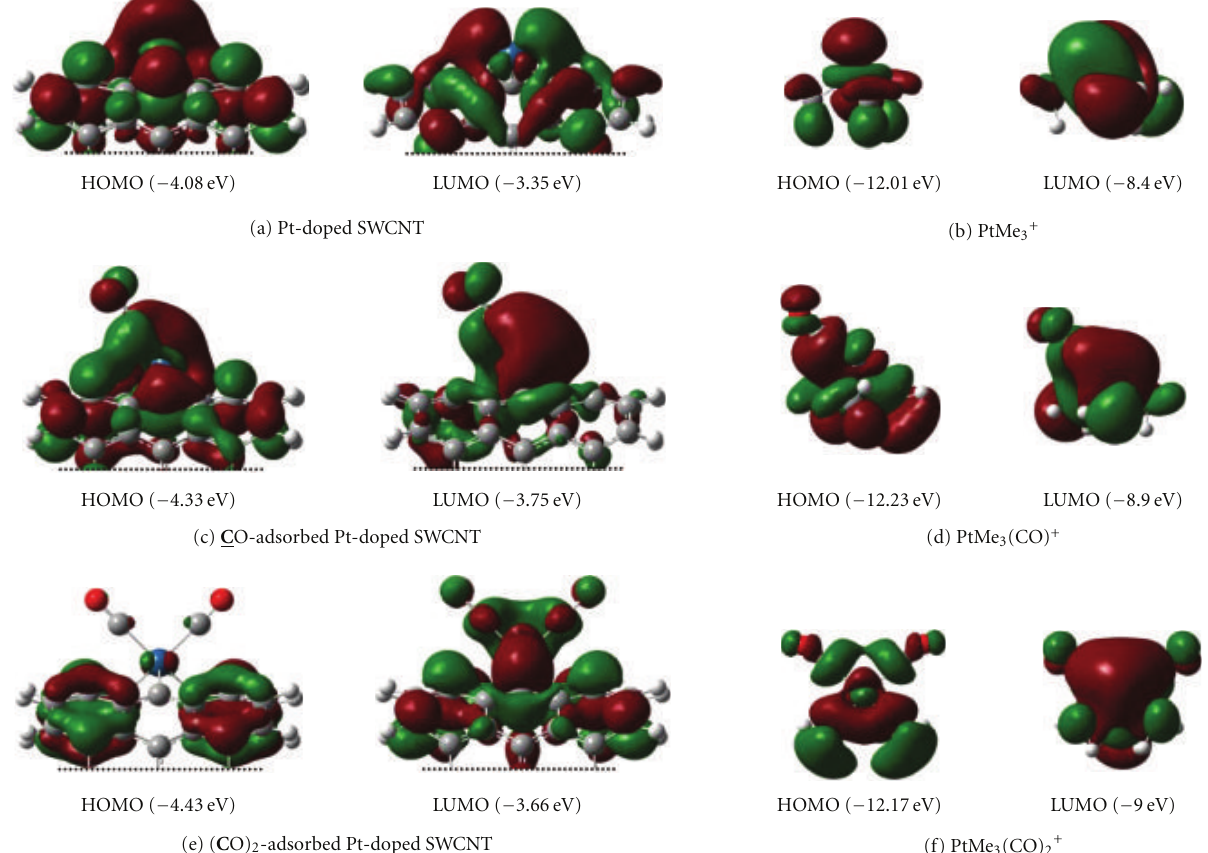
Figure 22: FMOs for the alkylplatinum complexes and Pt-doped SWCNT. Orbital energies are in parentheses